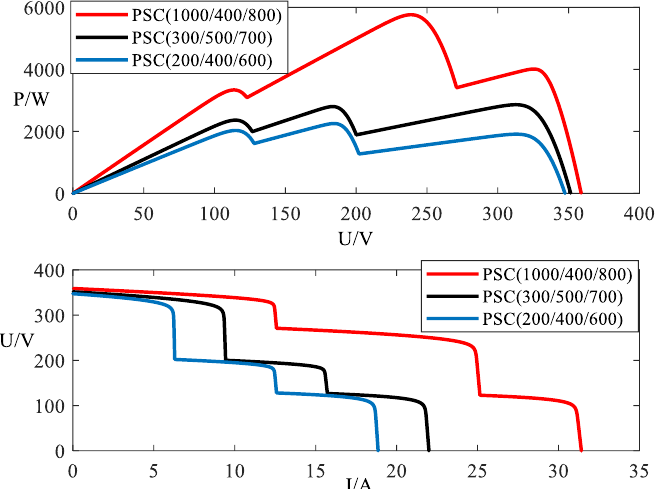
Figure 7. PV output characteristic curves under three different shading conditions.